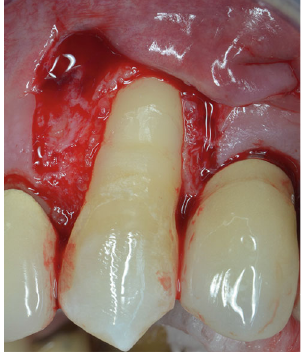
Figure 7: Root surface is treated with curettes and anatomical papillae